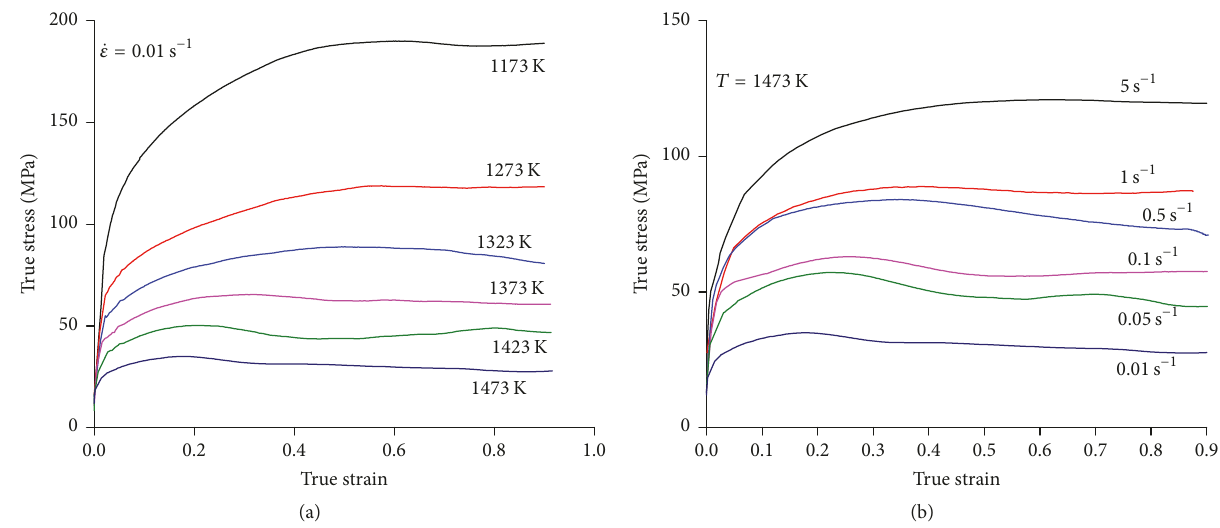
Figure 3: The true stress-strain curves of different deformation temperatures at strain rate of 0.1s −1 (a); different strain rates at deformation temperature of 1473 K (b).